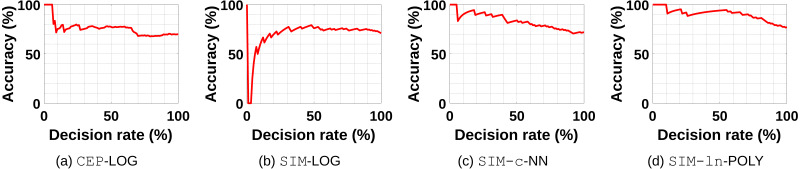
The exemplary performance of RECI if a certain decisions rate is forced.(A) CEP-LOG, (B) SIM-LOG, (C) SIM-c-NN, (D) SIM-ln-POLY. Here, the decisions are ranked according to the confidence measure defined in Eq. (23).